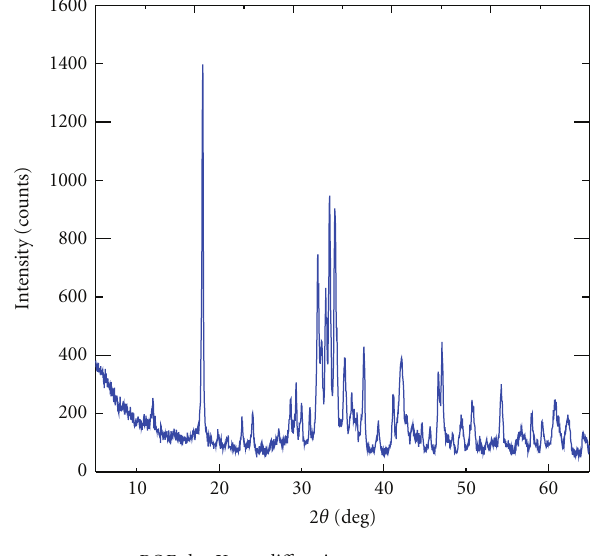
ff raction pattern for BOF slag.